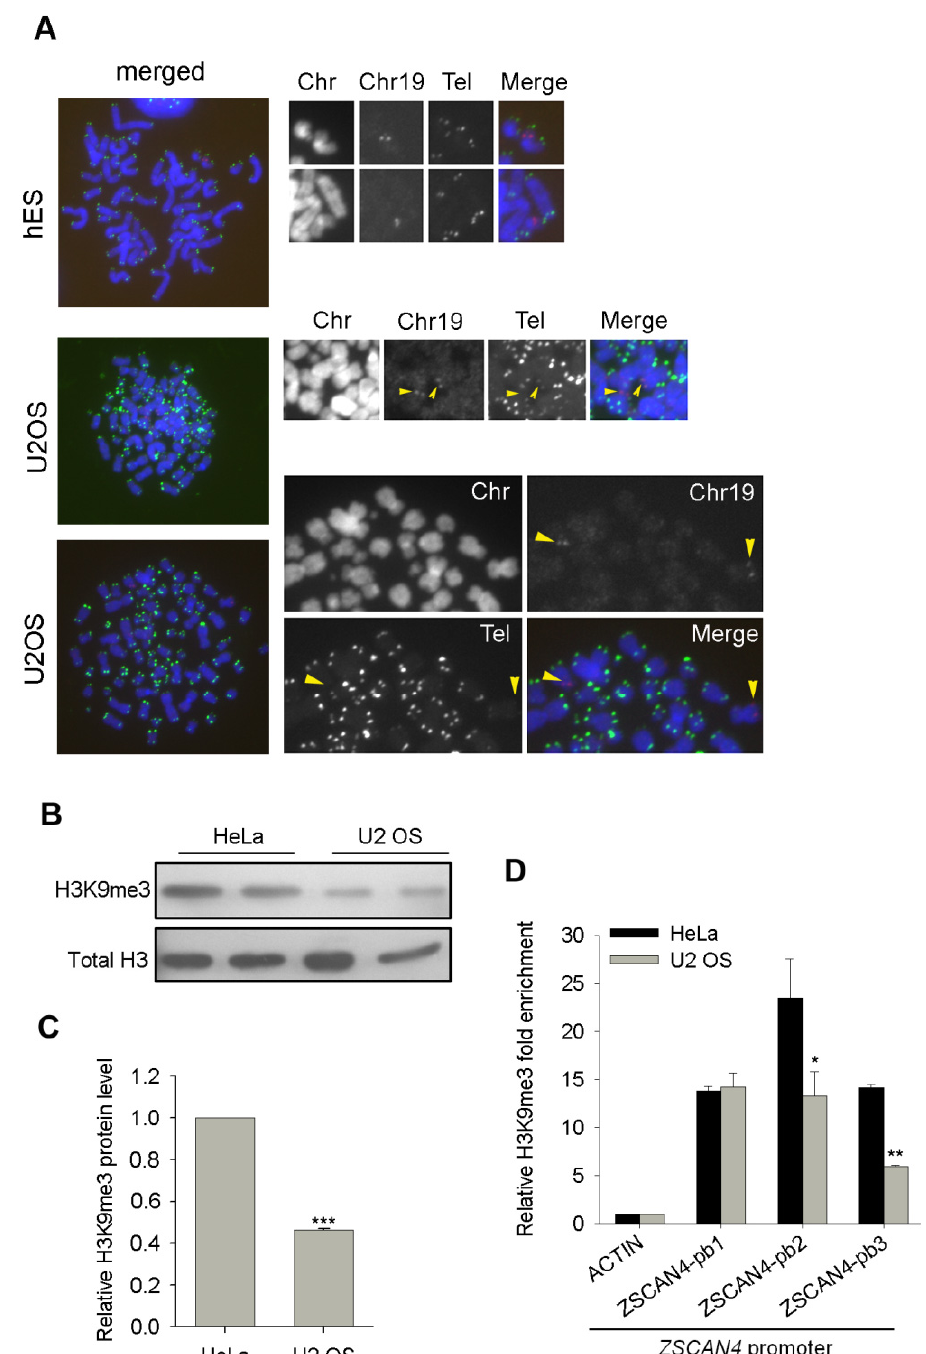
Figure 6. Heterochromatin de-repression activates ZSCAN4 in ALT-U2 OS cells. ( A ) Co-localization of telomeres and ZSCAN4 gene region on chromosome 19 in telomerase-positive hESCs and telomerase negative U2 OS cells. Orange arrowheads indicate telomere signals of chromosome 19 where ZSCAN4 gene locates. ( B ) Western blotting analysis of H3K9me3 levels between HeLa and U2 OS cells. ( C ) Relative protein quantity of H3K9me3 normalized to β -actin by Bio-Rad Quantity One software. Error bars indicate mean ± SEM ( n = 2). ***, p < 0.001, compared to controls. ( D ) ChIP-qPCR analysis of H3K9me3 occupancy at 3 proximal locations upstream to ZSCAN4 promoter at subtelomeric regions of chromosome 19. Relative fold enrichment was normalized to rabbit IgG-ChIP signals at the same regions, and the β -actin locus served as negative controls. ‘pb’ stands for promoter binding site. Error bars indicate mean ± SEM ( n = 2). *, p < 0.05, **, p < 0.01, compared to controls.